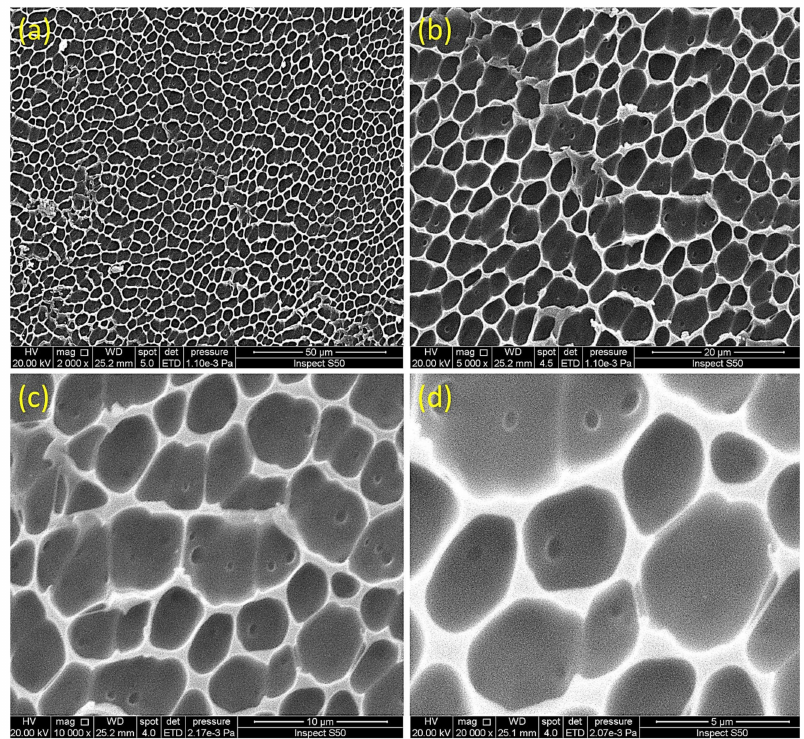
Figure 9. SEM images of PVC + 3 at magnification of ( a ) 2000 × , ( b ) 5000 × , ( c ) 10,000 × , and ( d ) 20,000 × .